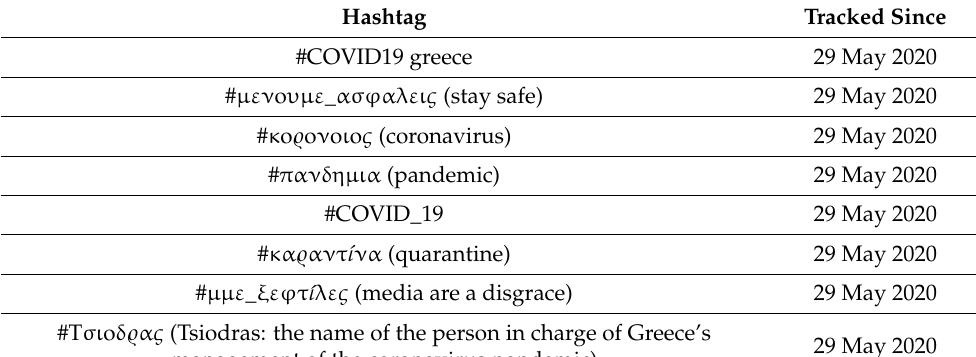
Table 3. Hashtags and date of collection. Hashtag Tracked